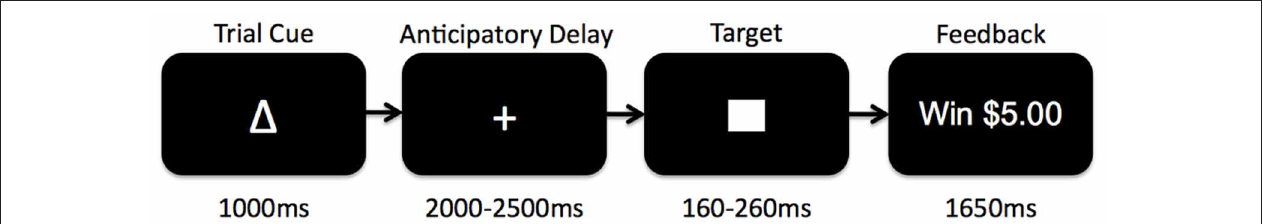
FIGURE 1 | SchematicdiagramoftheMonetaryIncentiveDelay(MID)task used in the currentstudy. Participants began each trial presented with 1 of 7 reward cues indicating whether they had an opportunity to gain reward, lose reward, or experience no change if they successfully pressed a button before a visual target disappeared on the screen. After the trial cue presentation,